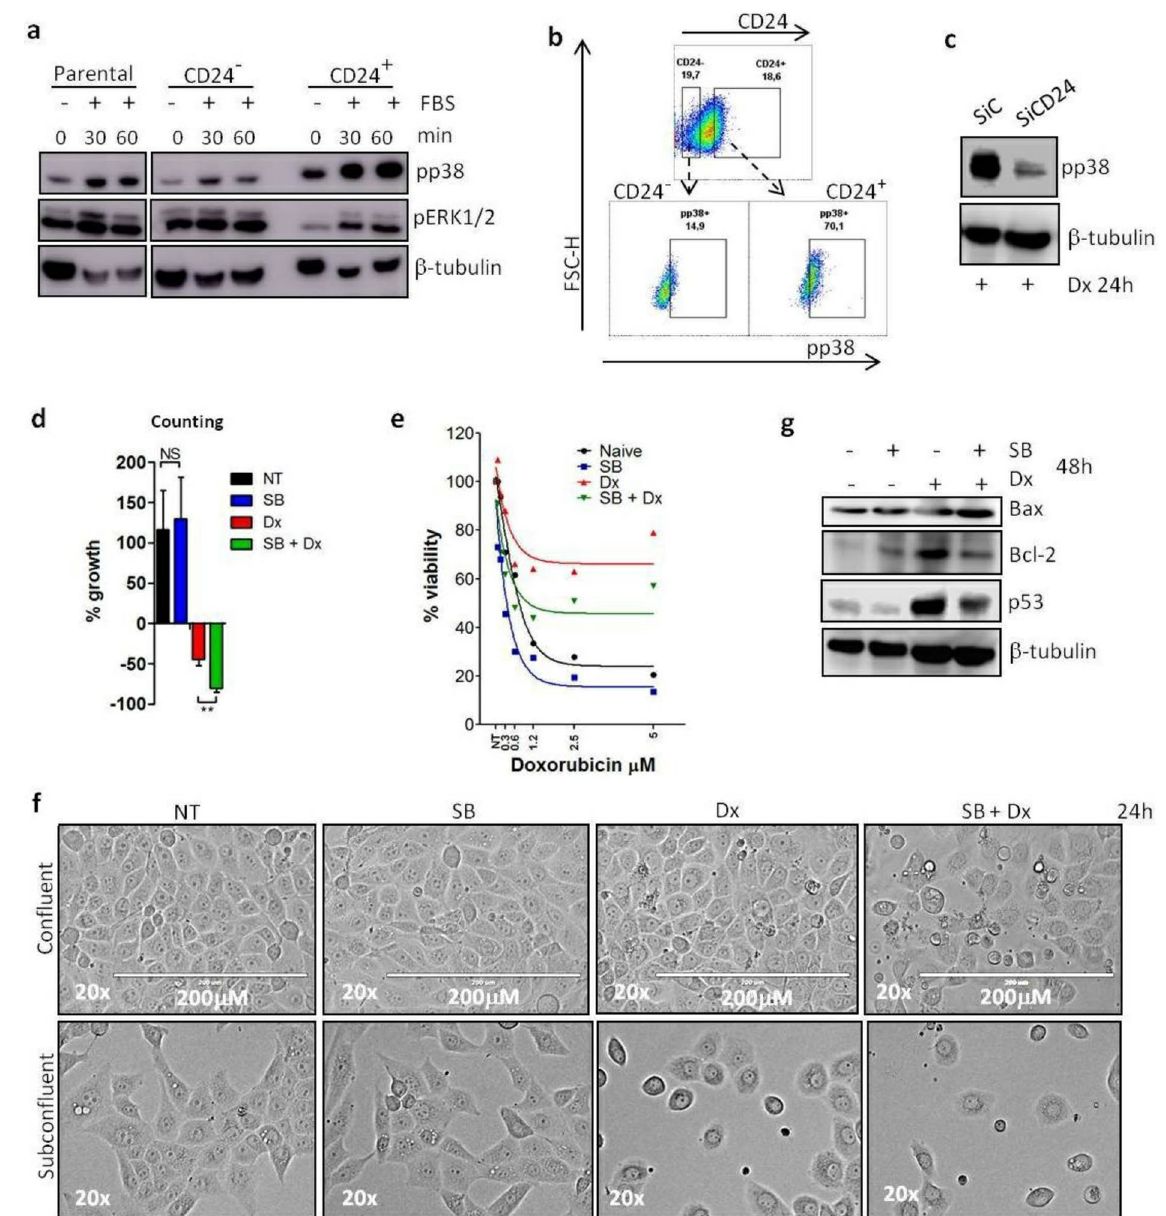
Figure 4. Inhibition of p38 activity impedes phenotype switching of MDA-MB-231 cells under doxorubicin treatment. ( a ) Differential activation of MAPKs in CD24 + and CD24 − subpopulation. Parental and the magnetic